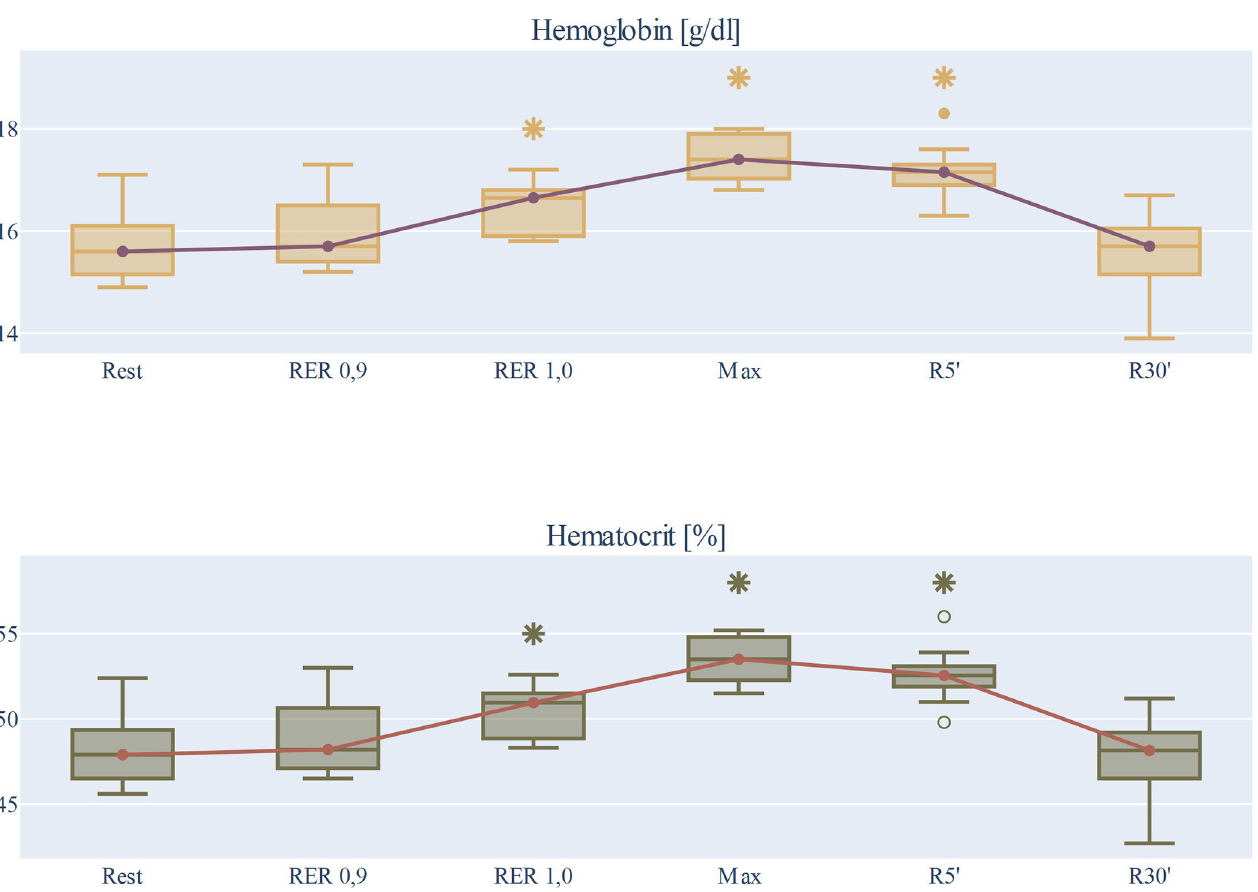
Fig 2. Changes in hemoglobin and hematocrit parameters during the short protocol. Rest: baseline values, sampling time before exercise. RER 0.9: median value 0.9 of the Respiratory Exchange Ratio (the aerobic range of the exercise). RER 1.0: median value 1.0 of the Respiratory Exchange Ratio (the anaerobic threshold of the exercise). Max: sampling time at the maximum exercise. R5’ and R30’: sampling times at the 5 th and 30 th minutes of the recovery period, respectively. The median, q1 and q3 quartiles, as well as the minimum and maximum values, are represented on the box plots. � Significant differences (p < 0.05) from resting